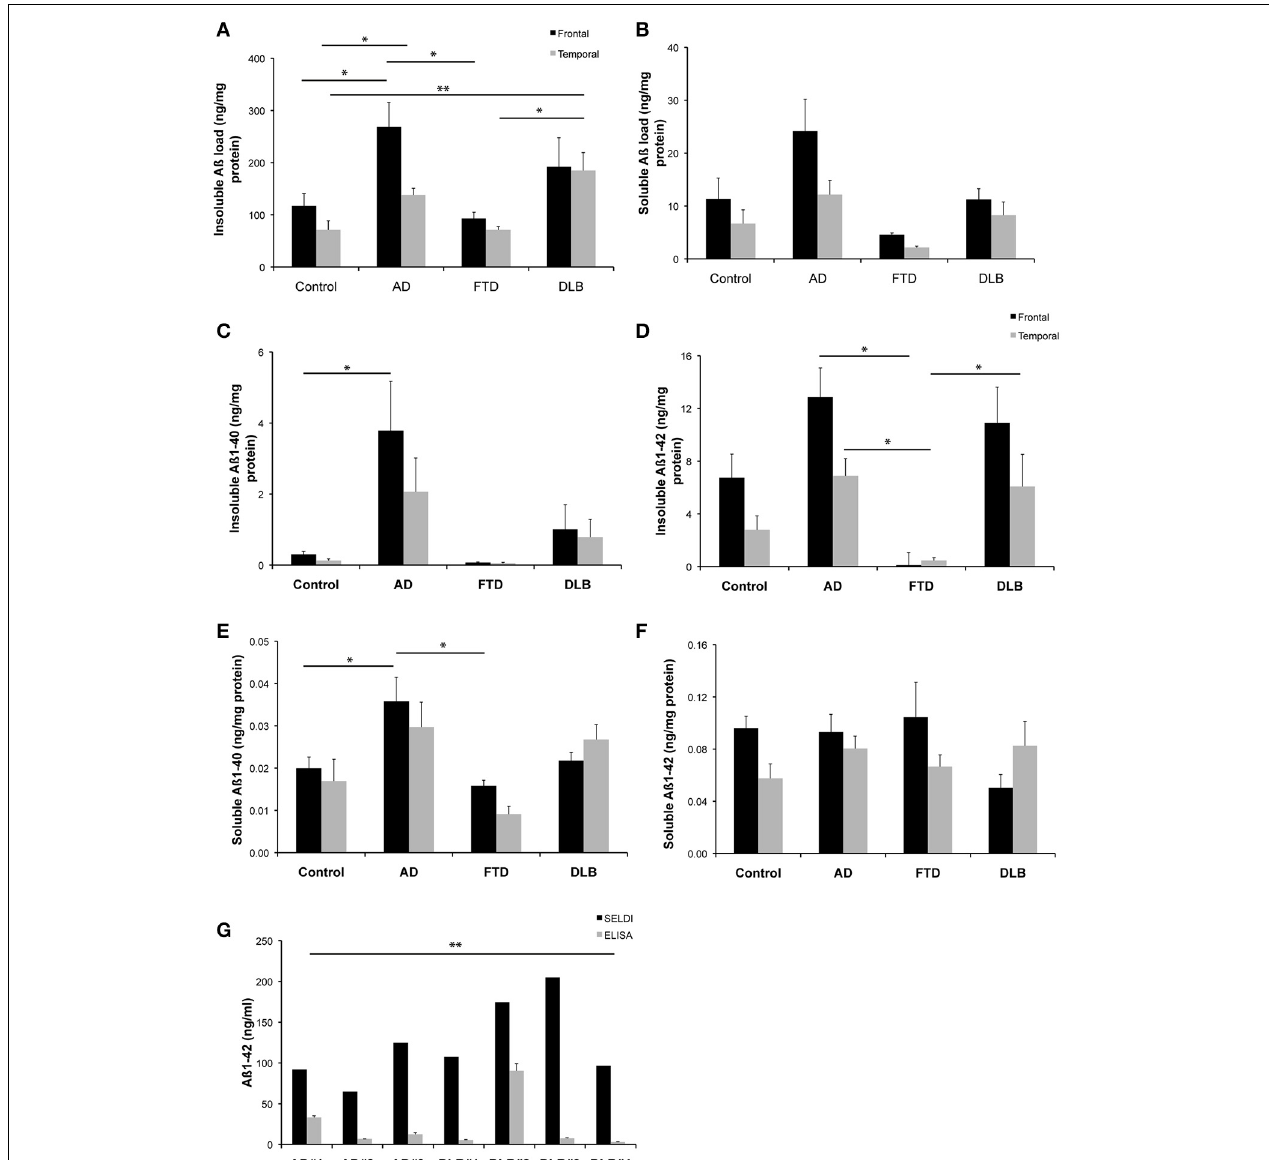
FIGURE 1 | Levels of A β detected in brain homogenates from a common set of human cases. (A,B) Western blot assessment of soluble and insoluble A β burden across the entire cohort of neurological cases and healthy control cases utilized in this study (C–F) ELISA assessment of soluble